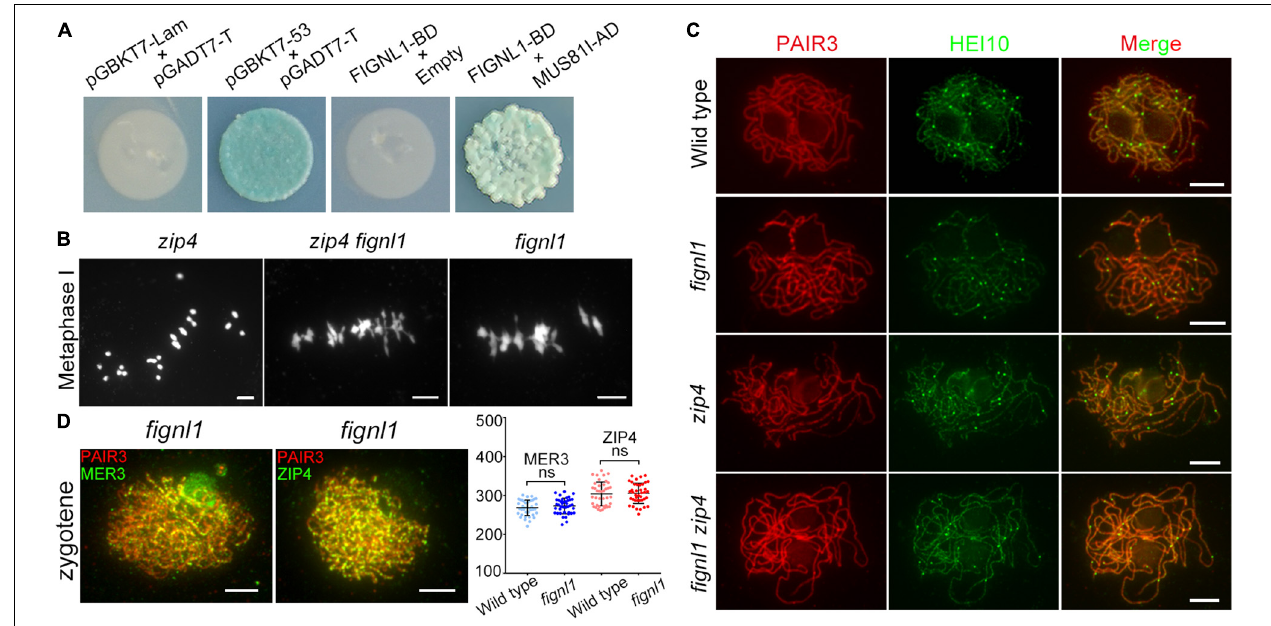
FIGURE 5 | FIGNL1 limits CO formation. (A) FIGNL1 interacts with MUS81 in yeast two-hybrid assays. The interactions were detected by the growth and the blue color of yeast on QDO/X/A. AD, prey vector; BD, bait vector. (B) The mutation of FIGNL1 restores bivalent formation in the zip4 background. (C) Localization of HEI10 is independent of FIGNL1. (D) No significant differences were observed in the numbers of MER3 and ZIP4 foci between the wild type and fignl1 mutant. Values are means ± SEM. ns, no significant difference according to two-tailed Student’s t -tests. Scale bars, 5 µ